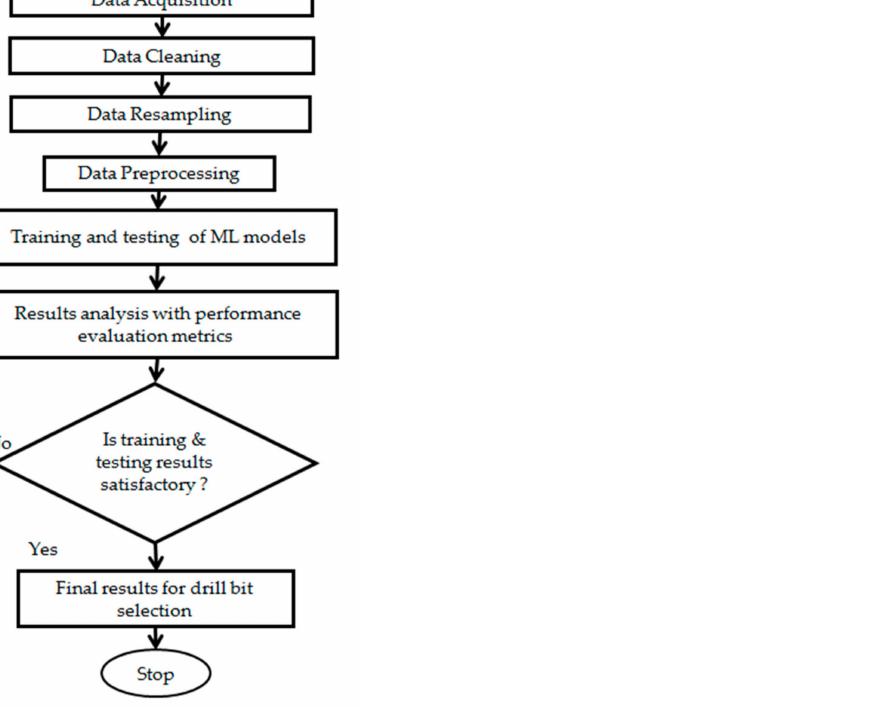
Figure 12. A generalized workflow of drill bit selection process based on the proposed